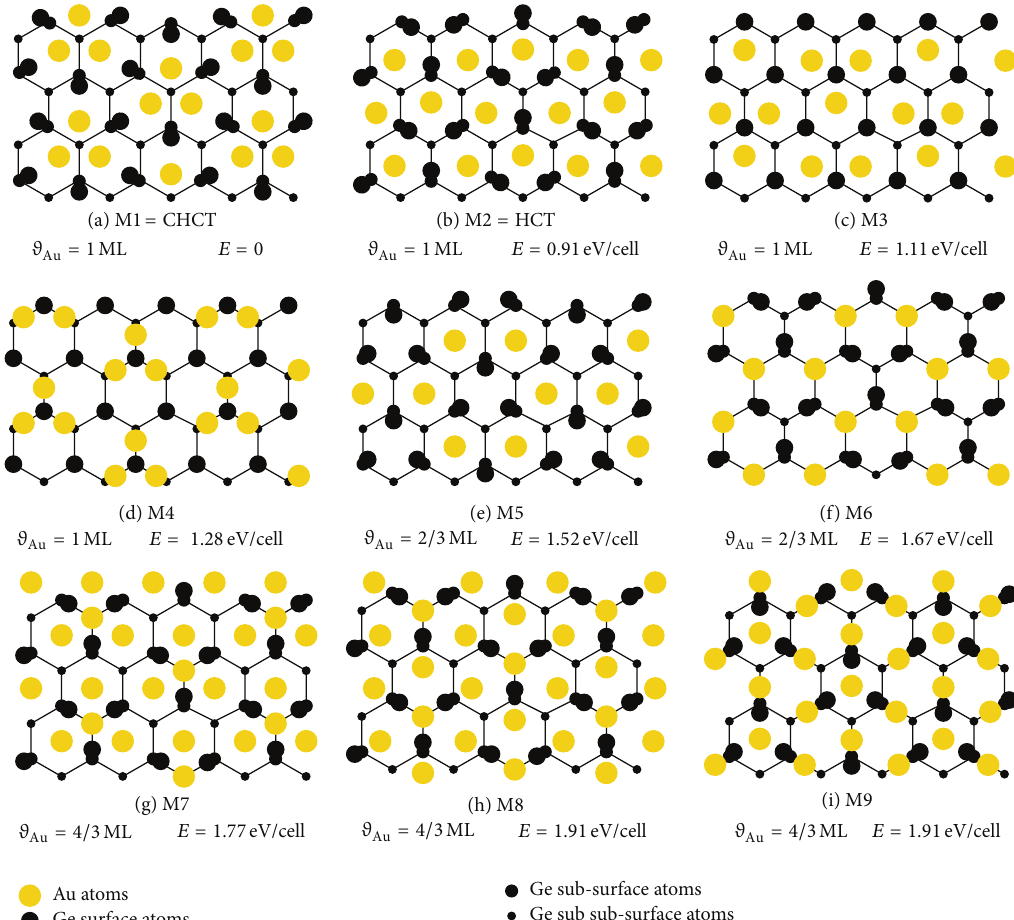
Figure 1: Top view of 9 energetically most favorable reconstruction models of the ( √3 × √3 )-Au/Ge(111) surface. 𝜗 the excess surface energy over the CHCT model.